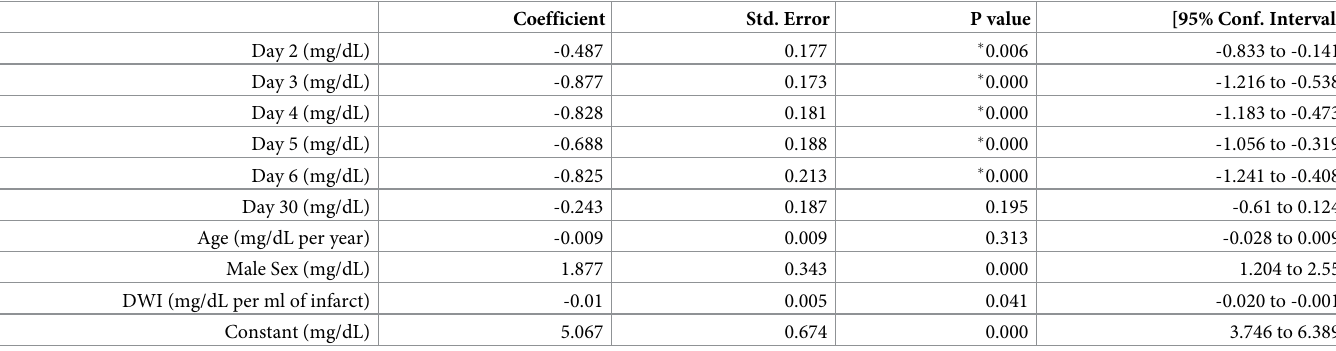
Table 2. Mixed model analysis for repeated measures of uric acid during follow up. � = significant. Coefficient Std.